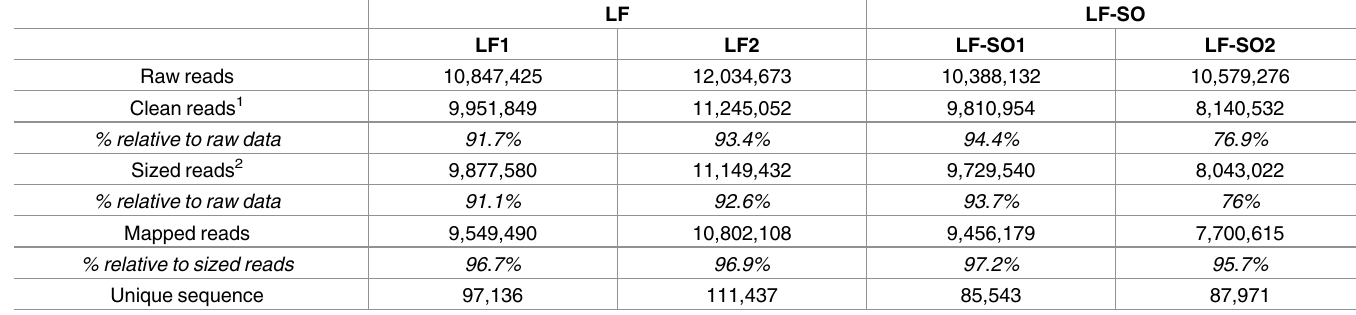
Table 1. Summaryof sequencing data. Cows receiveda low forage diet (LF) or the same diet supplemented with 4% of sunfloweroil (LF-SO).